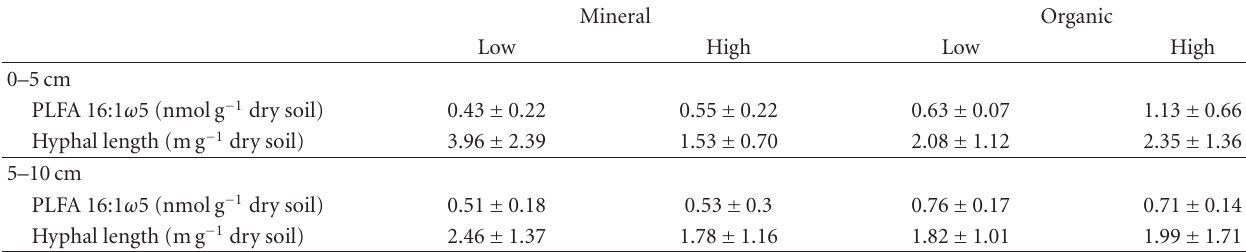
Table 2: Arbuscular mycorrhizal (AM) extraradical mycelium length and hyphal biomass in amaranth plots estimated morphologically